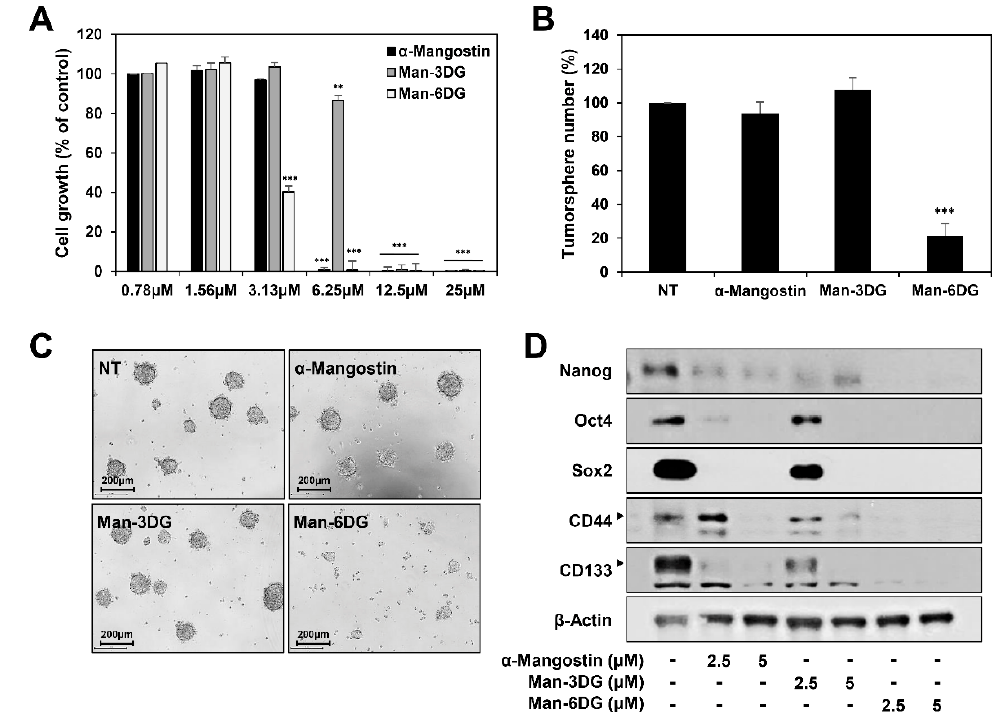
Figure 10. The e ff ects of α -mangostin glycosides on the tumorsphere formation and cancer stemness of Hep3B cells. ( A ) The e ff ects of α -mangostin, Man-3DG, and Man-6DG on the growth of 3D-cultured Hep3B cells. The cells were treated with increasing concentrations of three compounds (0–25 µ M) in serum-free suspended spheroid culture condition for 7 days. Cell growth was measured by CellTiter-Glo ® luminescent cell viability assay. ( B , C ) The e ff ects of α -mangostin, Man-3DG, and Man-6DG on the tumorsphere formation of Hep3B cells. The cells were treated with three compounds (3.13 µ M) in the 3D culture environment for 7 days. The number of formed tumorspheres in each well was counted under an optical microscope. ( D ) The e ff ects of α -mangostin, Man-3DG, and Man-6DG on the expression of cancer stemness markers in Hep3B cancer stem-like cells. The cells were treated with three compounds (2.5 and 5 µ M) for 24 h, and the protein levels were detected by western blot analysis using specific antibodies. The levels of β -actin were used as an internal control. Each value represents the mean ± SD from three independent experiments. ** p < 0.01 and *** p < 0.001 versus the control.